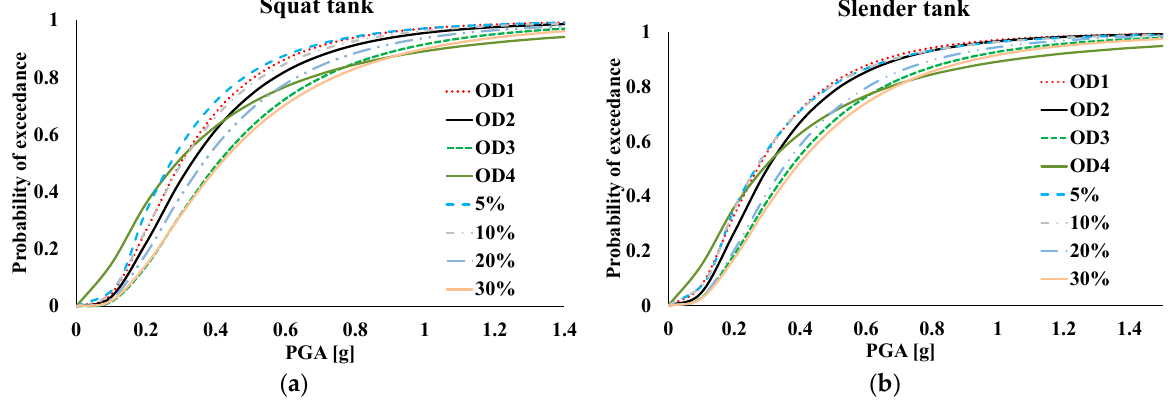
Figure 5. Fragility curves for MOGA1 designs for: ( a ) the squat and ( b ) slender tank.